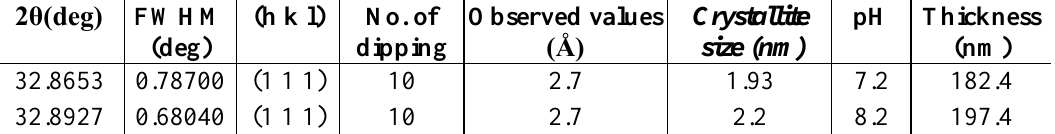
Figure (1): XRD patterns of cadmium oxide films at the two pH values. Table 1: XRD parameters of CdO thin films of the two pH values at a concentration of 0.2